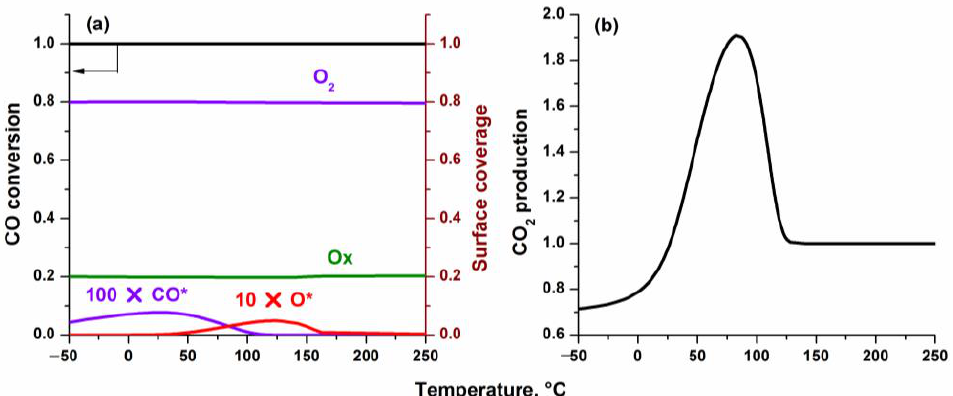
Figure 12. Temperature dependencies of ( a ) CO conversion and the coverages of the platinum by adsorbed CO, O, O 2 , and oxide species and ( b ) CO 2 production for the Pt-C catalyst. The concentrations of O 2 and CO were 5 vol.% and 50 ppm, respectively. The estimated rate constants are k 6 = 6.75 × 10 5 s − 1 · bar − 1 , k − 6 = 10 13 e − 26 RT s − 1 , k 7 = 0.0037 s − 1 · bar − 1 , k 8 = 1.5 × 10 2 e − 7 RT s − 1 , 𝑘 9 = 19 − 29 10 13 𝑒 − 𝑅𝑇 s − 1 , 𝑘 10 = 10 13 𝑒 𝑅𝑇 s − 1 , and 𝑘 11 = 75 s − 1 ·bar − 1 . The values of the parameters character-